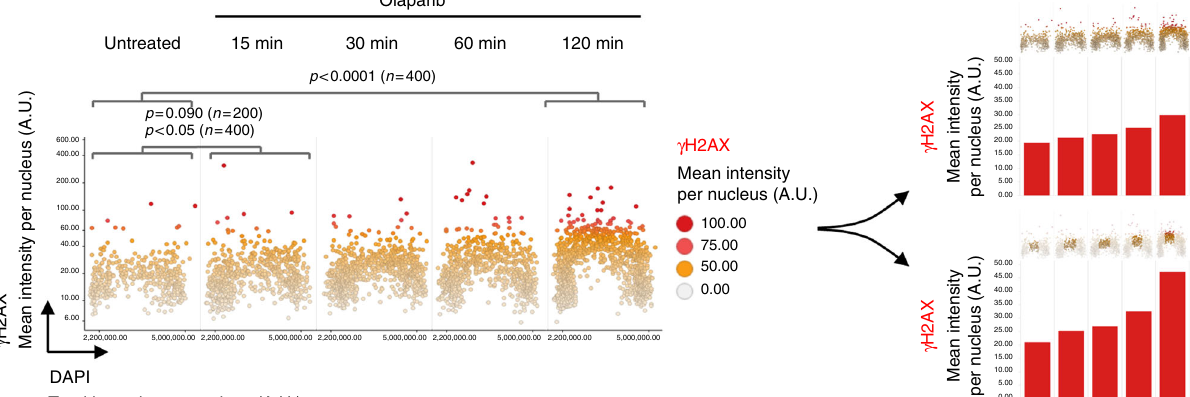
Fig. 1 Quantitative analysis of PARP inhibitor toxicity by multidimensional fl uorescence microscopy. a Asynchronously growing populations of adherent U-2 OS cells were treated with 10 μ M olaparib for 4 h, fi xed and stained for DNA content (DAPI) and the genotoxic stress marker γ H2AX. Scatter plots depict mean γ H2AX and total DAPI intensities per nucleus. Each dot represents a single cell. Representative images of the untreated and olaparib-treated cell populations and individual cells are shown on the right. b U-2 OS cells were treated with the indicated PARPi (all 10 μ M) for 4 h and stained for γ H2AX and DNA content as before. γ H2AX levels are shown as a function of cell cycle progression. A representative picture of niraparib-treated cells is shown on the right. c Cells were treated as indicated, pre-extracted on ice in 0.2% Triton X-100 for 2 min prior to fi xation, and stained for γ H2AX and DNA content. γ H2AX was quanti fi ed as a function of cell cycle progression. On the right, bar charts depict γ H2AX levels as cell population averages from the same time- course either focused on the whole cell population (top right) or on cells in mid S-phase (bottom right). Note that focusing the analysis on speci fi c sub- populations only (e.g., excluding cells in G1 and G2) greatly enhances the dynamic range of the analysis. p -values were obtained by Mann – Whitney test. Color codes as de fi ned in the fi gure panels. Scale bars, 100 μ m (large image fi elds) and 10 μ m (single cell